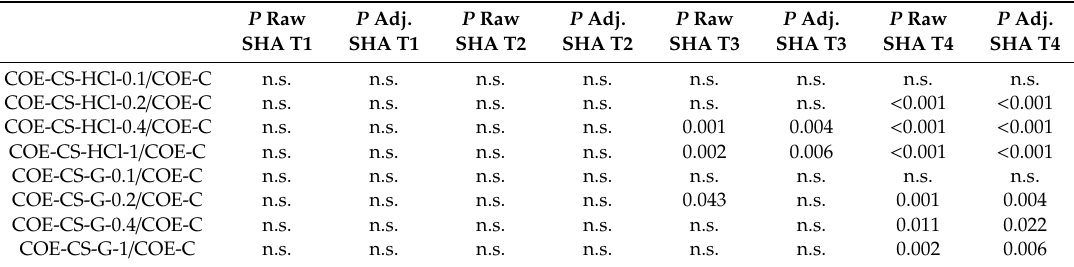
Table 3. Shore A hardness p -values ( ≤ 0.05) raw and adjusted (adj.) by Bonferroni-Holm correction for Coe-Soft.